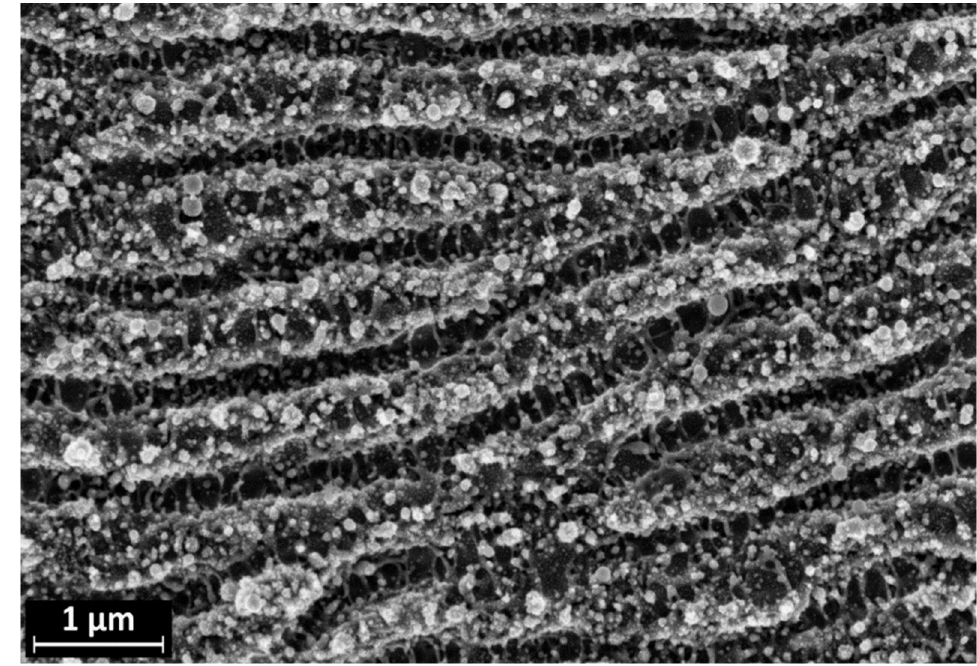
Figure 3. SEM image of the AISI 301H sample after LIPSS processing.